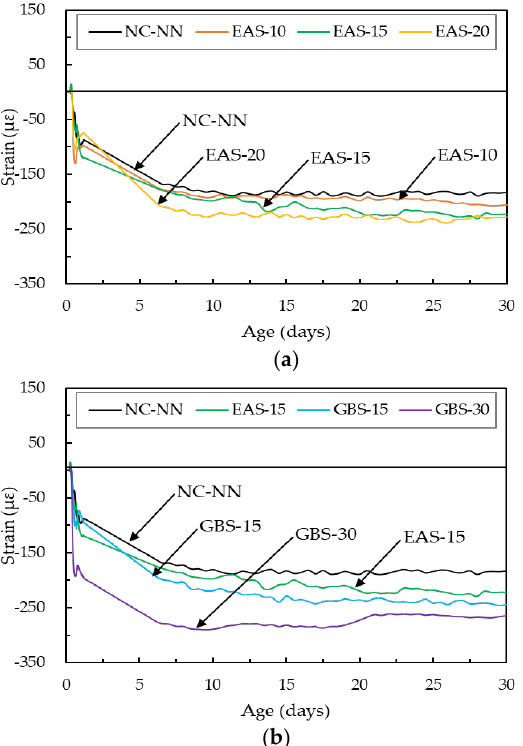
Figure 8. Autogenous shrinkage behavior: ( a ) HSC containing EAS; ( b ) HSC containing GBS.